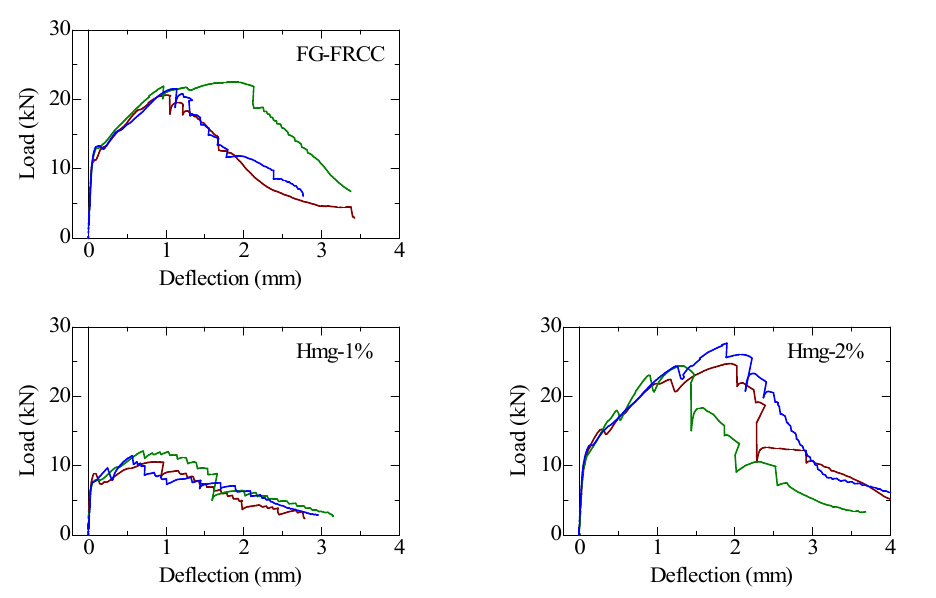
Figure 5. Applied load–deflection curves of 1st day series specimens.